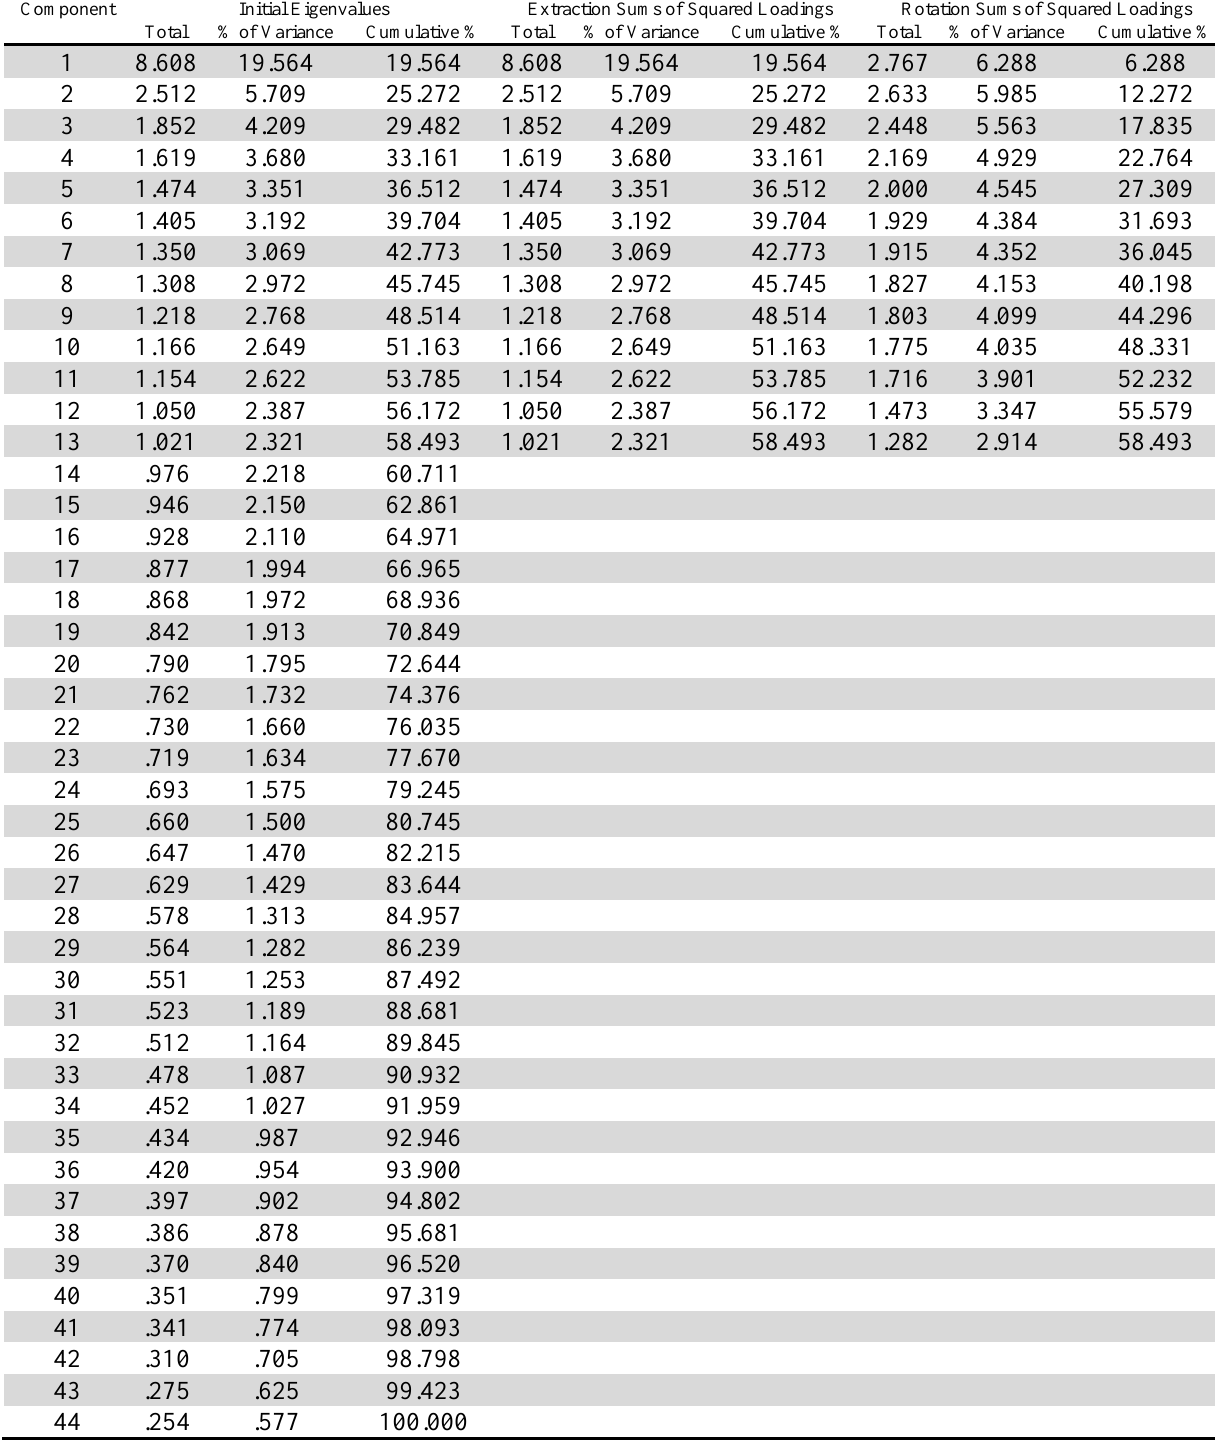
The summary of principal component